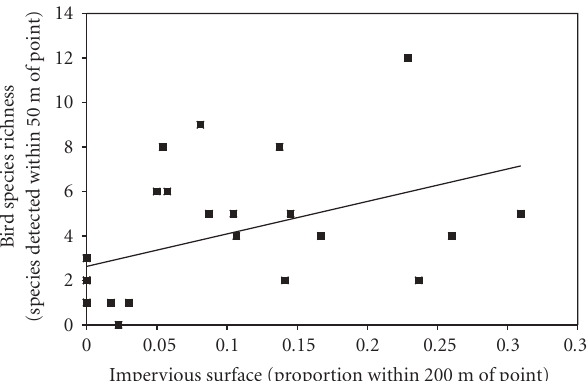
Figure 1: Bird species richness measured at the per-point scale increased with increasing exurbanization. The number of bird species detected during 5 minute point counts was higher at points that had higher proportions of impervious cover around them (linear regression: P = .010, R 2 = 0.22, df = 1,27).